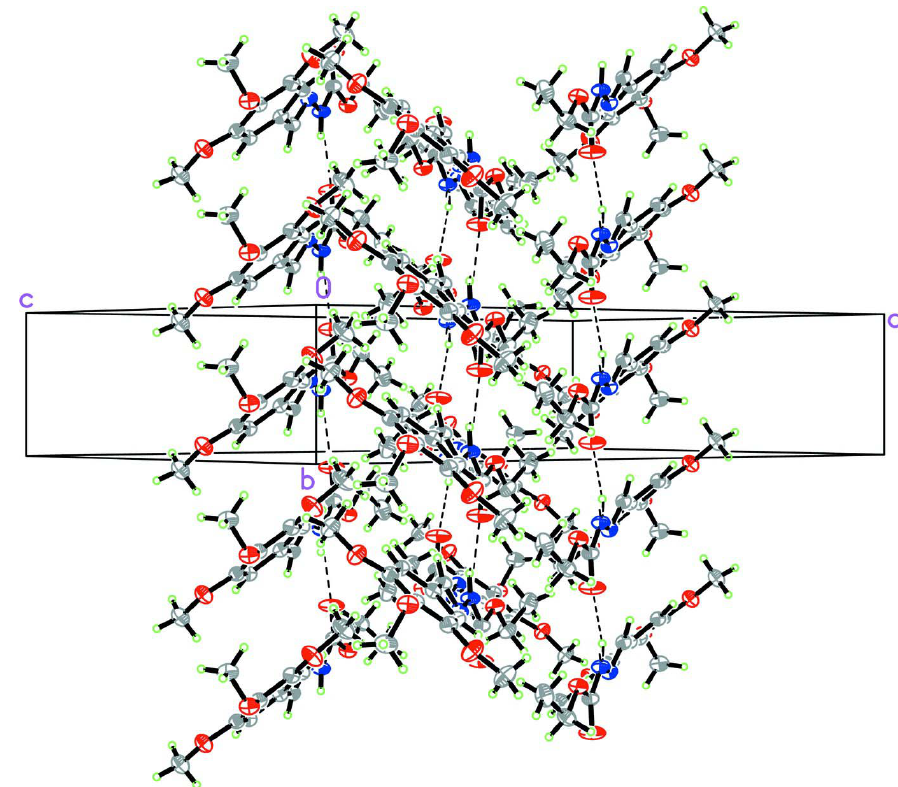
Figure 2 Crystal packing of the title compound, viewed approximately down the a axis. Dashed lines indicate intermolecular hydrogen